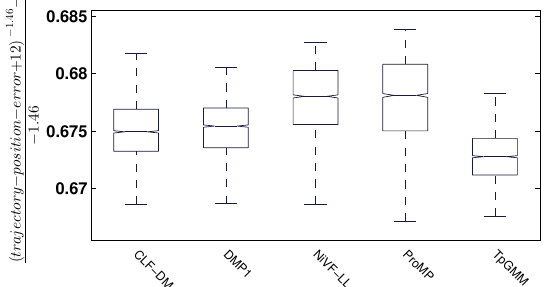
(c) Results of all trained modules over all shapes in the gener- alization benchmark scenario. Figure 5: Exemplar plots illustrating different comparisons. In par- ticular, these plots show the “trajectory-position-error", however, those plots can be generated for each measure described in Sec- tion